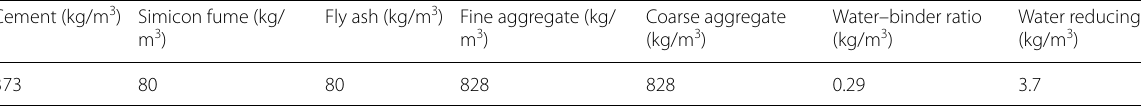
Table 3 The mix proportion of steel-fiber concrete.